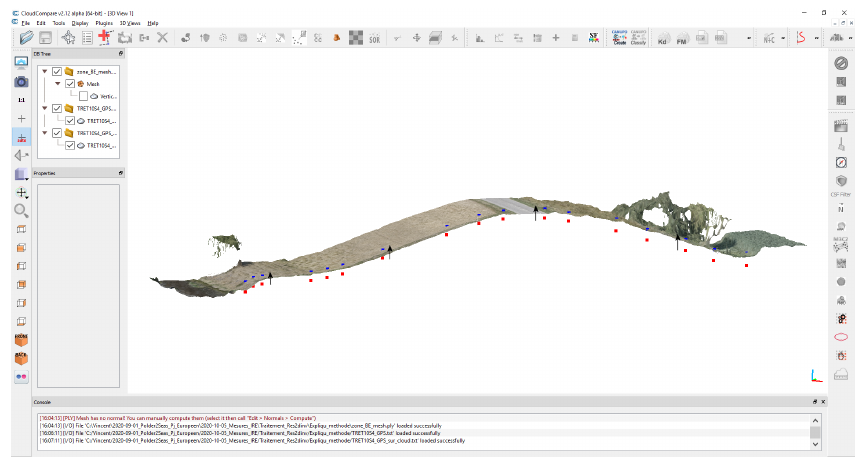
Figure 5. Snapshot of the 17 GPS points (red squares) and UAV-based DTM for the T10 profile as seen within CloudCompare. GPS points are manually corrected in the vertical direction (black arrow), to be as close as possible to the DTM using the Point List Picking Tool in CloudCompare (corrected positions are labelled by blue squares).